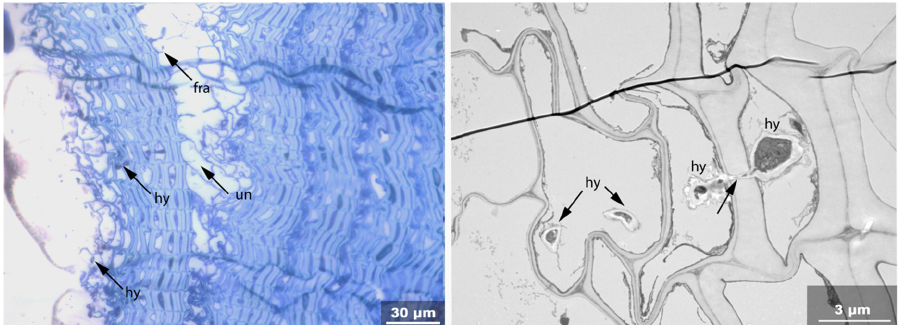
Figure 10. Reference sample. LM images ( left ): delamination due to breaking of boundary radial cell walls (fra) accompanied by unfolding of compressed thin-walled cells (un). TEM images ( right ): hyphae within thin-walled cell lumen and penetrating all wall layers.